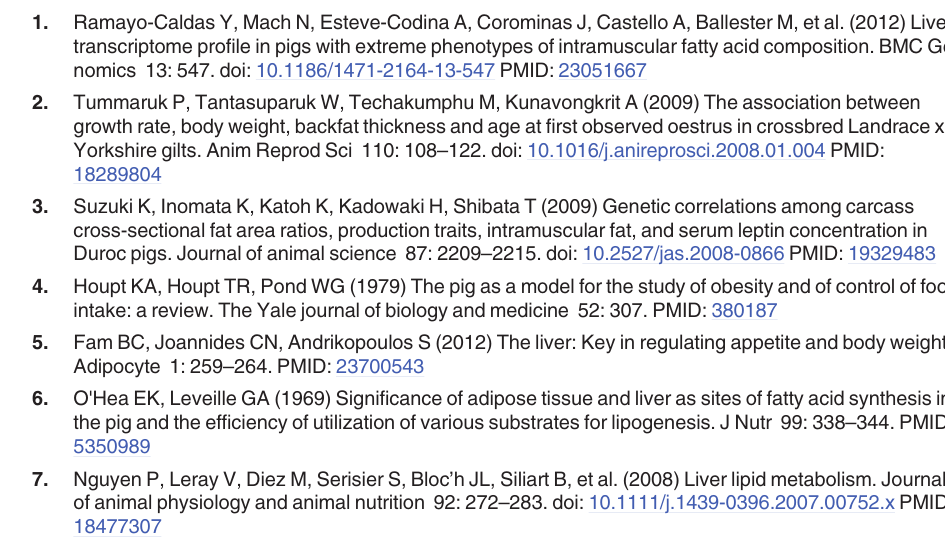
S4 Table. DEGs common among the three different pairs. S5 Table. Details of gene ontology categories for differently expression genes. S6 Table. SNPs and indels only in BH and BL annotated in genes. S7 Table. Genes with NS or cIndel annotated in DAVID. S8 Table. SNP and indels by type in differently expression genes. S9 Table. Information of overlapping between DEGs and QTLs related to fat traits. S10 Table. Detail information of common DEGs compared with other